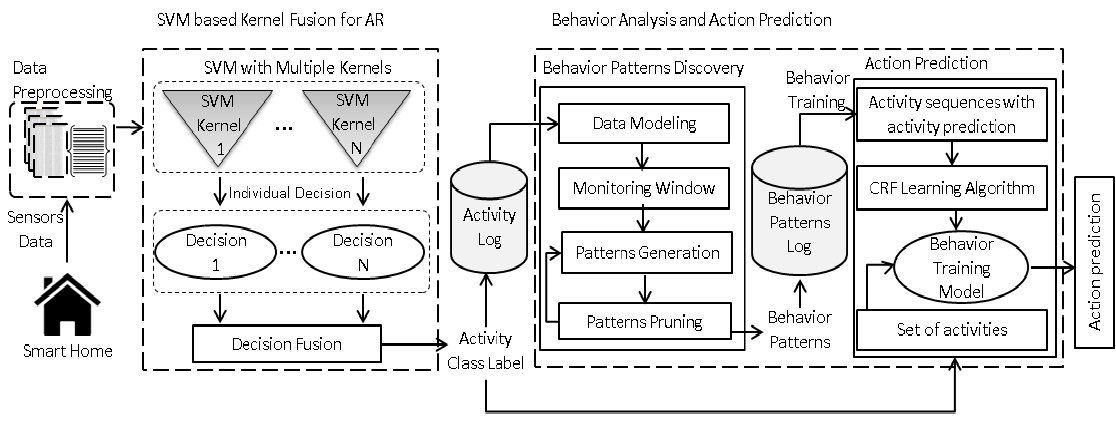
Figure 1. The architecture of the proposed